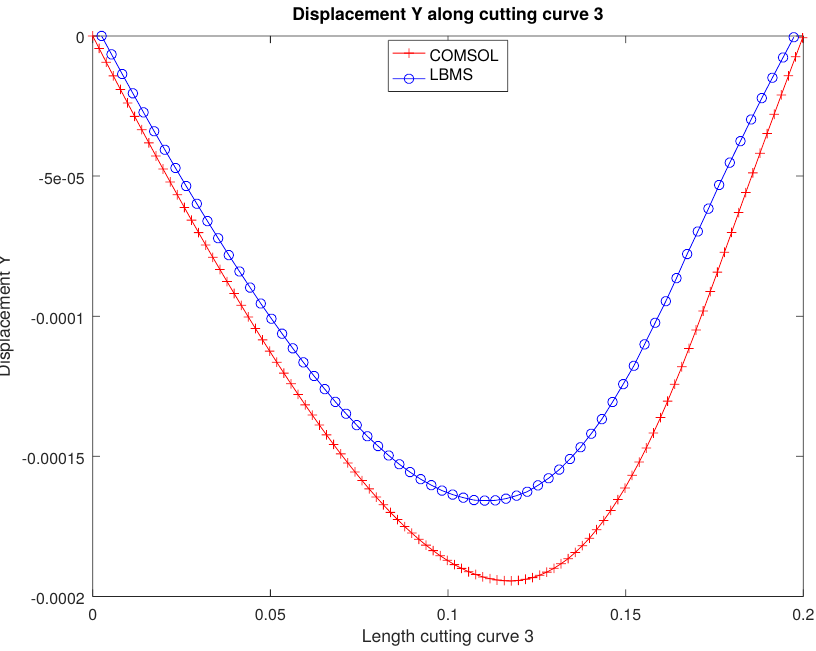
Figure A23. Second displacement components along cutting curve C 3 for case E = 200 GPa, ν = 0.15 with triangular